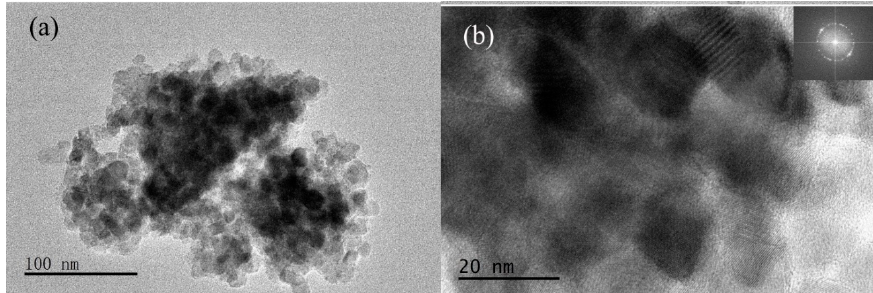
Figure 5. TEM ( a ) and HRTEM ( b ) images of 0.50% Yb/TiO 2 . HRTEM: high resolution transmission electron microscope.